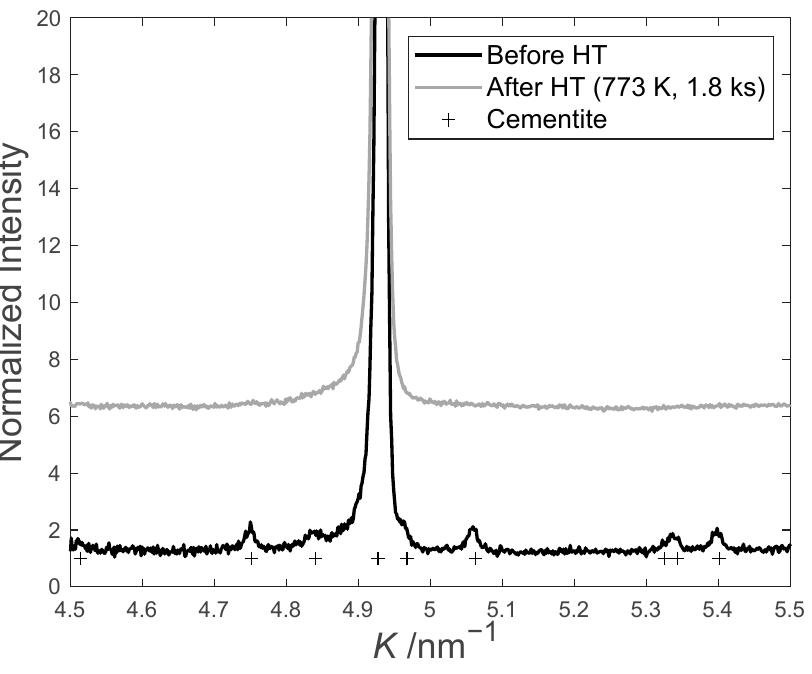
Figure 8. Diffraction patterns near the 110 α peak observed before (black) and after (gray) the heat treatment process with austempering at 773 K for 1.8 ks. The cementite peak positions are indicated by “+”.